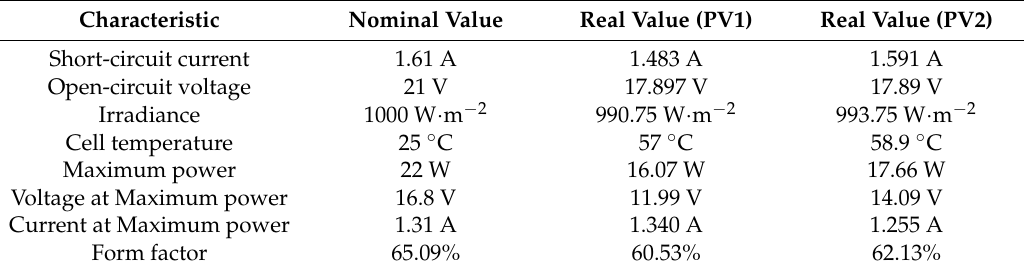
Table 2. Nominal and real electrical characteristics of photovoltaic